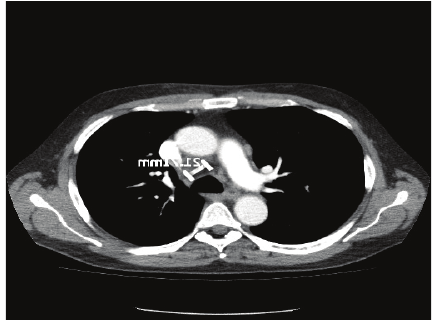
Figure 1: CT scan (pretreatment) showing lymph nodes.